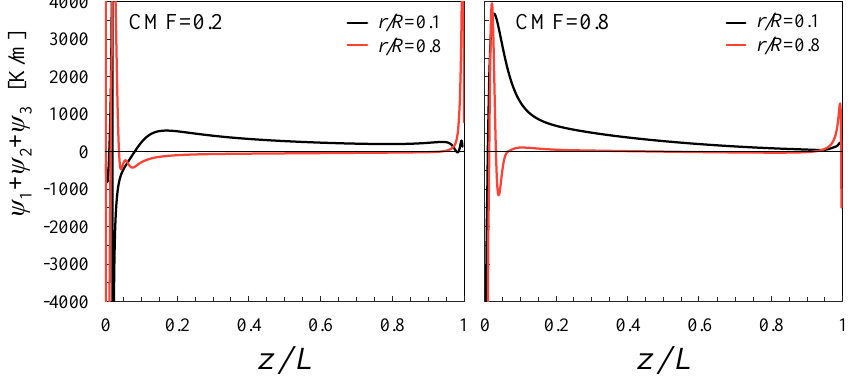
 ,  , and  along the axial-direction line at r / R = 0.8. 1 2 3